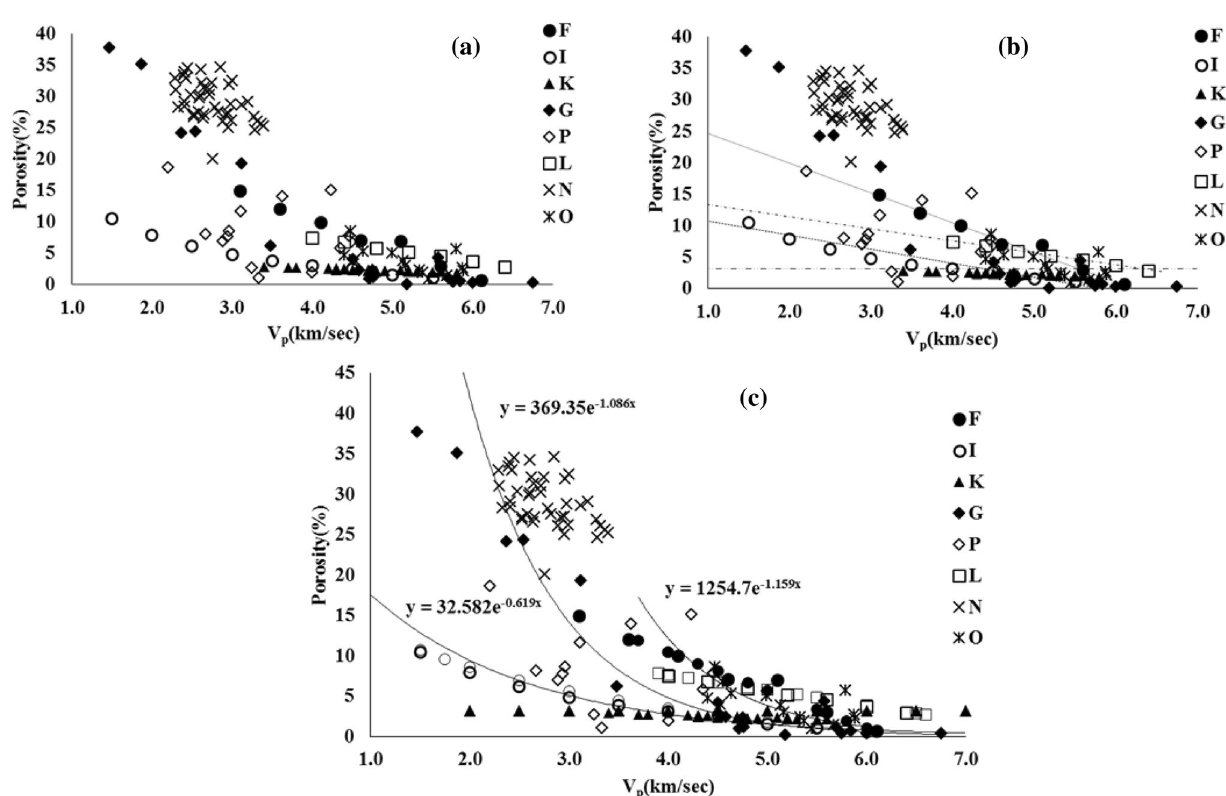
Fig. 3 V p versus porosity a as reported by different researchers, b including empirical relationships generated by various researchers (datasets plotted as symbols while lines represent empirical equation)